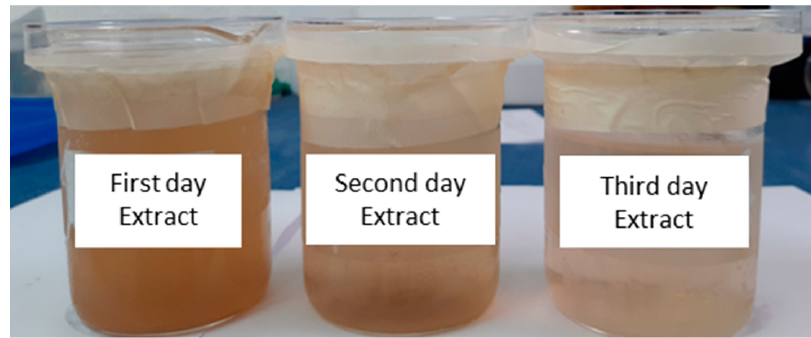
Figure 2. Extracts from green banana peel prepared by the decoction method.